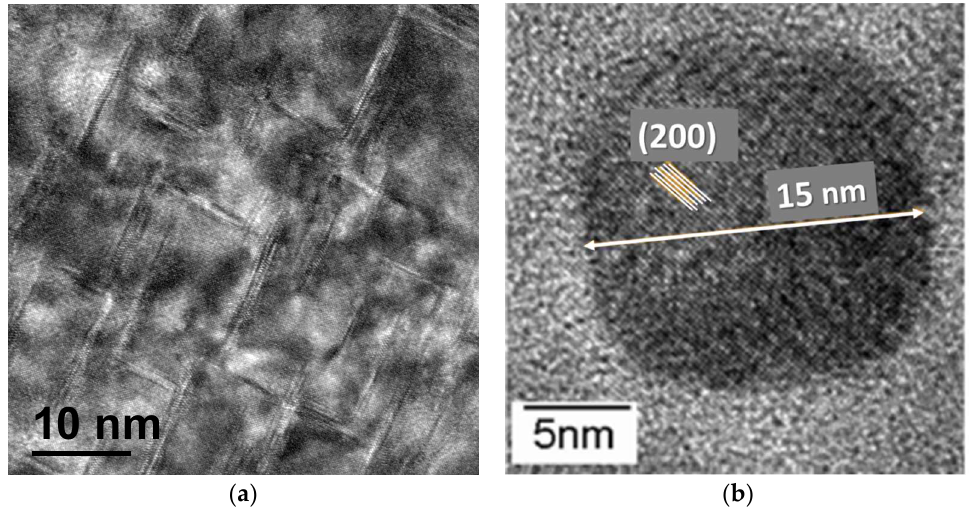
Figure 3. ( a ) High-resolution transmission electron microscopy (HR-TEM) micrograph recorded along the [001] zone axis. In this configuration, only two variants are visible, the third, lying parallel to the surface, is hidden; ( b ) High-resolution view on a single nitride obtained from a replica, with (200) fcc planes in the precipitate indicated.